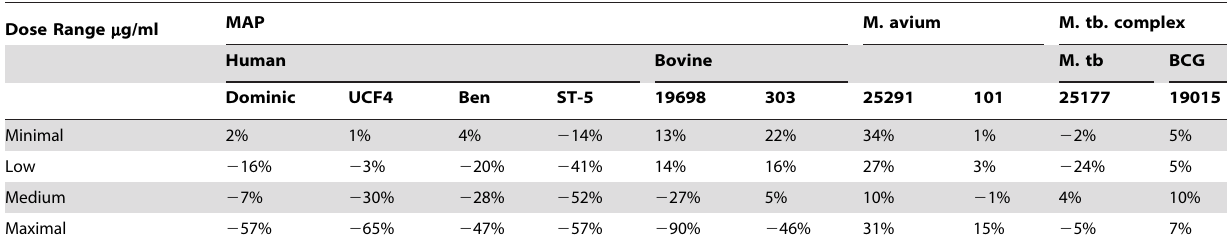
Table 4. Methimazole.